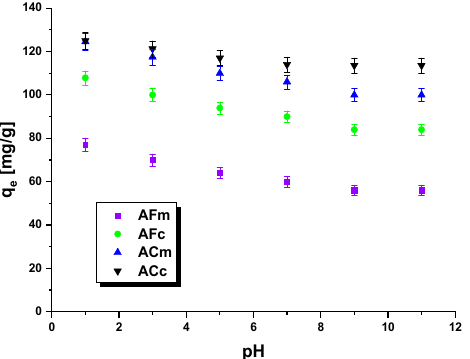
Figure 7. Effect of pH on the removal of methyl red sodium salt by biocarbons.